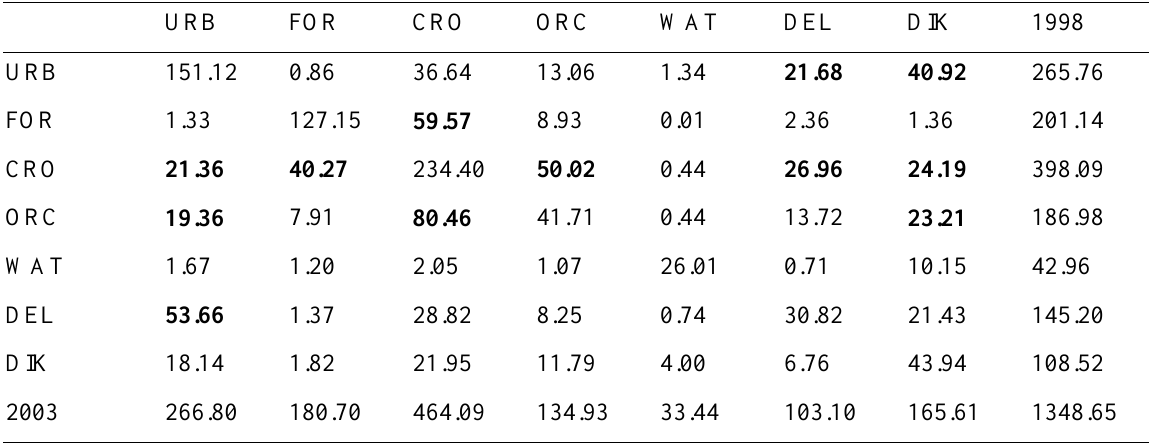
Table 2. Land use change matrix in Guangzhou from 1998 to 2003 (km 2 ). URB FOR CRO ORC WAT DEL DIK 1998